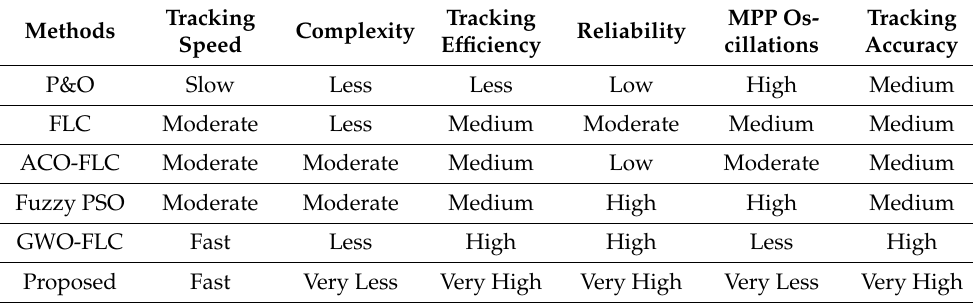
Figure 22. Comparative analysis based on tracking time and efficiency. Table 2. Qualitative comparative analysis. Table 2. Qualitative comparative analysis.